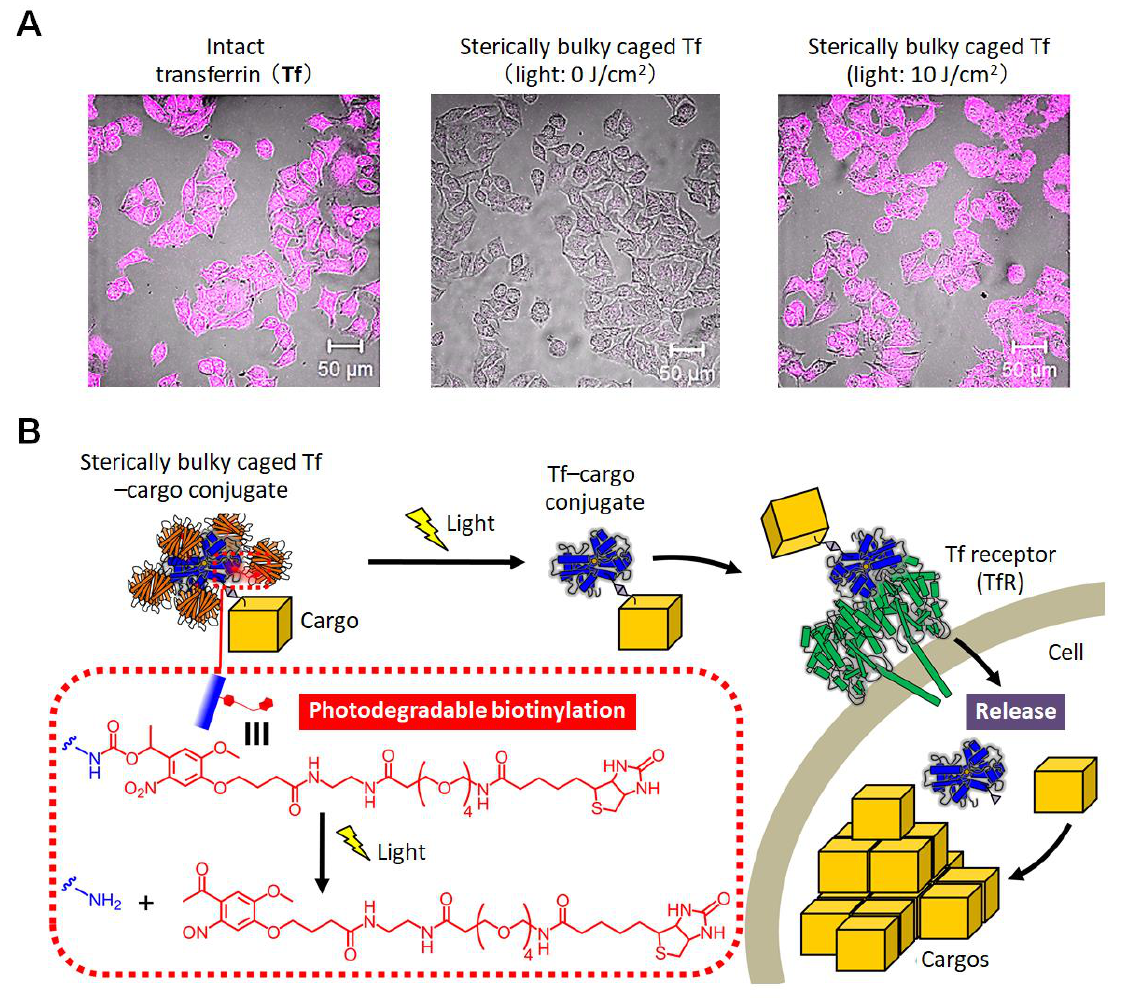
Figure 4. Sterically bulky caging of transferrin (Tf). ( A ) Fluorescence microscopy images of colon cancer DLD1 cells treated with intact Tf or sterically bulky caged Tf after exposure to light at 0 and 10 J/cm 2 [68]. ( B ) Schematic illustration of light-induced intracellular delivery of cargos by using sterically bulky caged Tf [68].